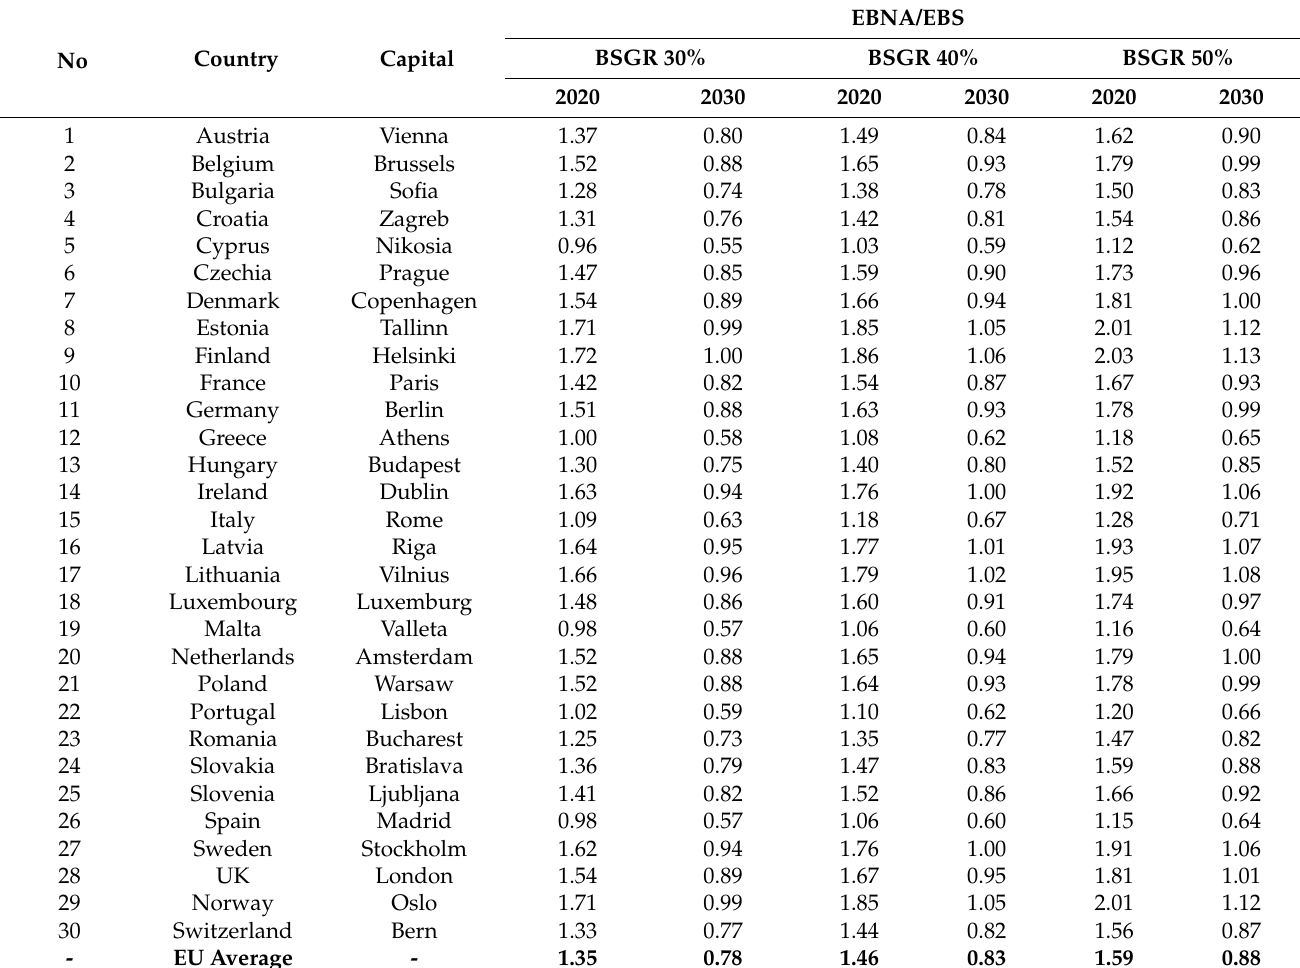
Figure 8. The correlation of the geographical irradiation potential of BS and the building orientation in Stavanger. Table 4. The ratio values of the energy consumption of the BNA (EBNA) to the energy production of the BS (EBS) per square metre for the European